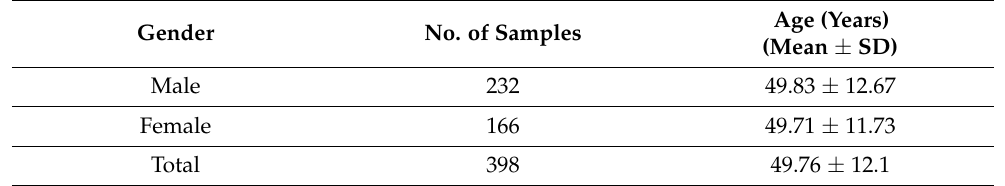
Table 2. Summary of data collection at